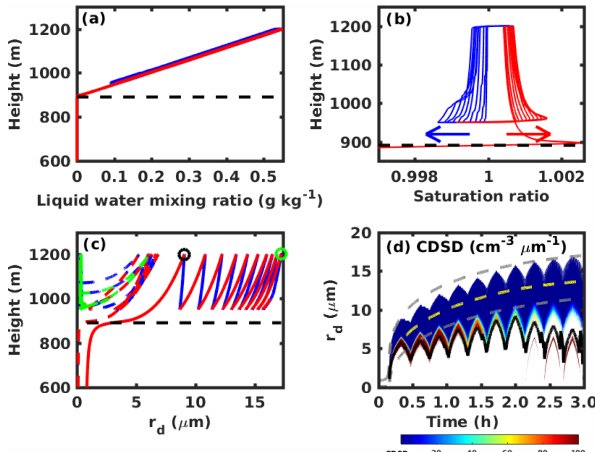
Figure 2. Thermodynamical and microphysical properties of an adi- abatic cloud parcel with upward and downward oscillations. (a) Liq- uid water mixing ratio changes with height. (b) Cloud parcel satura- tion ratio changes with height. Arrows in (b) represent the evolution of the saturation ratio profile with time. (c) Radii changes of two selected cloud droplets with height. The solid line is for the largest cloud droplet that formed on a dry aerosol with a radius of 503nm, and the dashed line is for a droplet that formed on an aerosol of 51nm. The red and blue lines in (a) – (c) represent ascending and descending parcels, and the black dashed line indicates cloud base height. The green dashed line indicates the reactivation of that grid. The black and green circles are referred to in the text. (d) Cloud droplet size distribution changes with time. The black line repre- sents the mean cloud droplet radius change with time. The yellow dashed line is the change in mean droplet size for the ascending- only cloud parcel with a constant velocity of 0 . 5ms − 1 , and the up- per and lower dashed gray lines represent the largest and smallest cloud droplets in the ascending-only